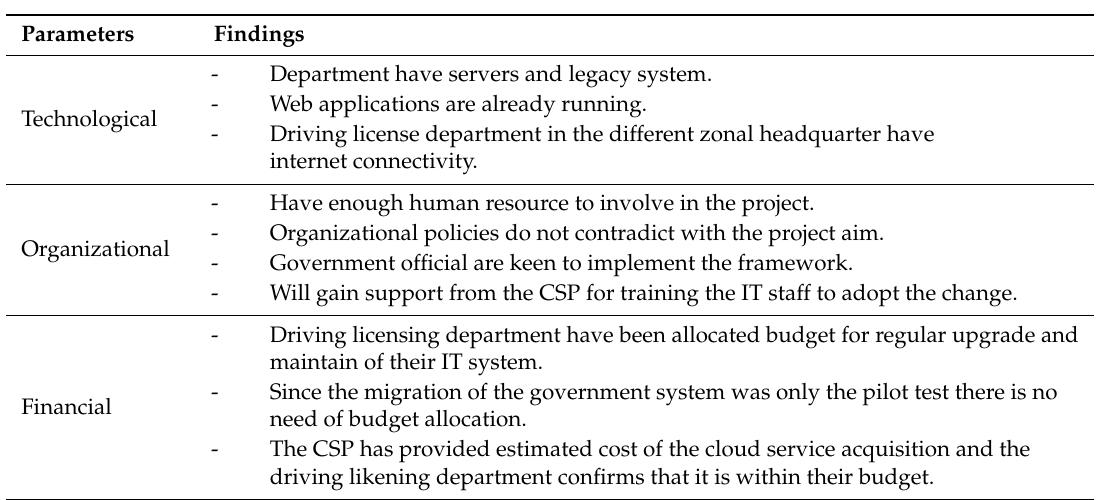
Table 3. Feasibility study